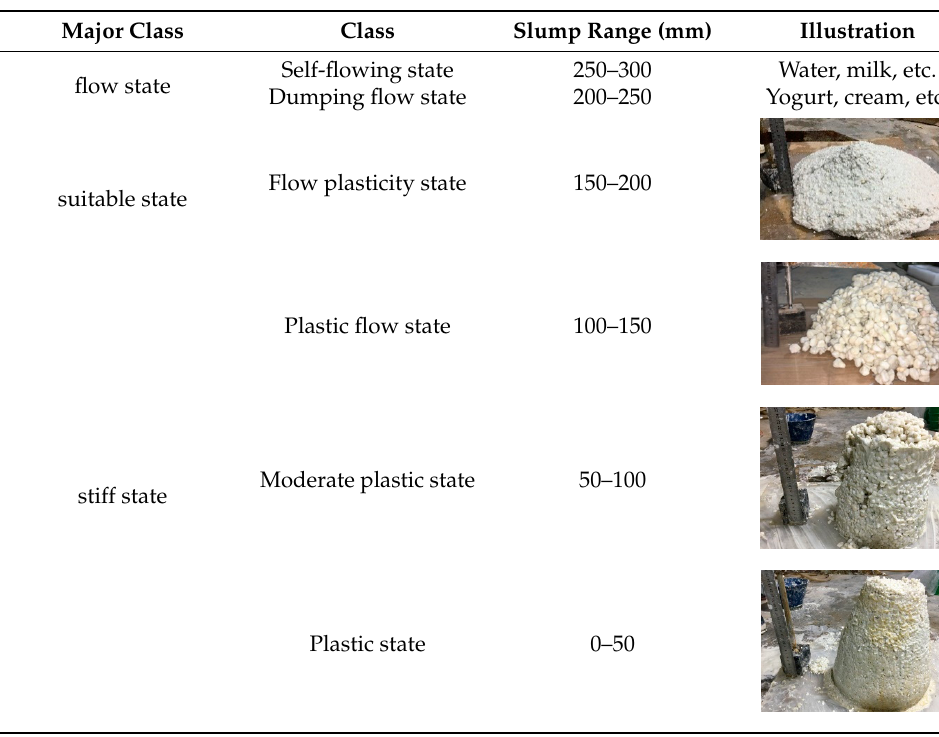
Figure 6. Changes of slump with various injection ratio on different sandy gravel particle sizes. 370 Table 8. Conditioned sandy gravel state classification. 371